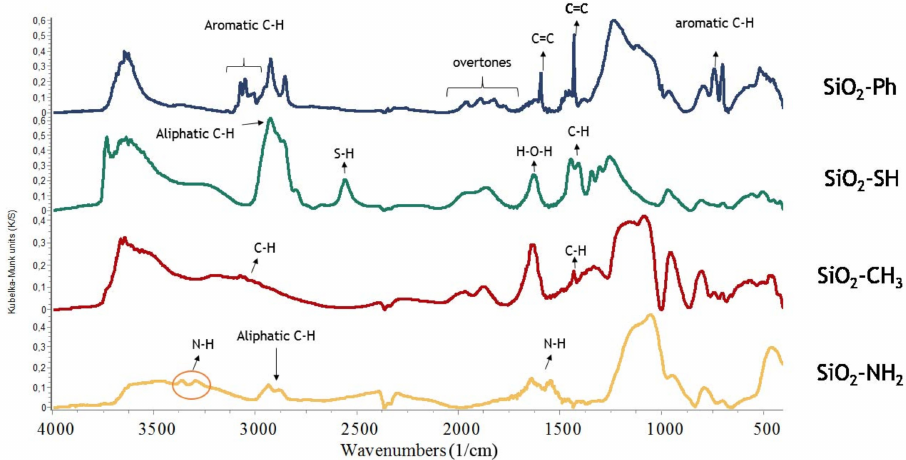
Figure 6. IR spectroscopy of SiO 2 –Ph, SiO 2 –SH, SiO 2 –CH 3 , and SiO 2 –NH 2 . Phenyl-modified silica: a number of bands from 3100 to 3000 cm − 1 characterize stretching vibrations of aromatic C–H bonds. The peaks at 2925 cm − 1 and 2850 cm − 1 refer to asymmetric and symmetric stretching vibrations of C–H bonds. The range of bands from 2000 cm − 1 to 1750 cm − 1 are overtones of the aromatic ring. The band on 1594 cm − 1 —in-plane stretching vibrations of the C=C bond of the phenyl fragment. The 1431 cm − 1 band includes stretching vibrations C=C and bending C–H vibrations of the aromatic ring. The weak peak at 1000 cm − 1 characterizes the symmetric stretching vibra- tions of the C=C bond. The peak on 950 cm − 1 shows in-plane stretching vibrations of the Si–O bond, 793 cm − 1 —symmetric stretching vibrations of Si–O bonds, and the band on 742 cm − 1 —out-of-plane vibrations of the C–H phenyl fragment. C–H bonds. The peak at 2558 cm − 1 —S–H stretching vibration band. The band on 1627 cm − 1 —deformation vibrations of adsorbed water. The peaks at 1446 cm − 1